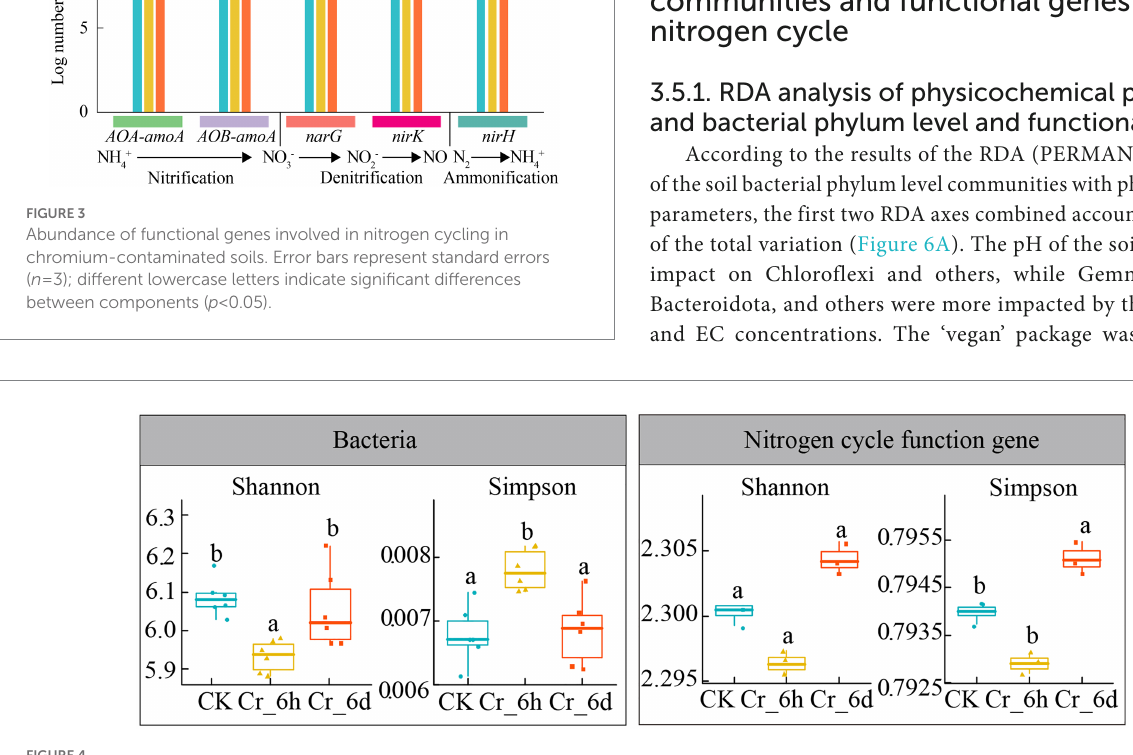
(Supplementary Figure S3; Supplementary Table S4) were Mantel